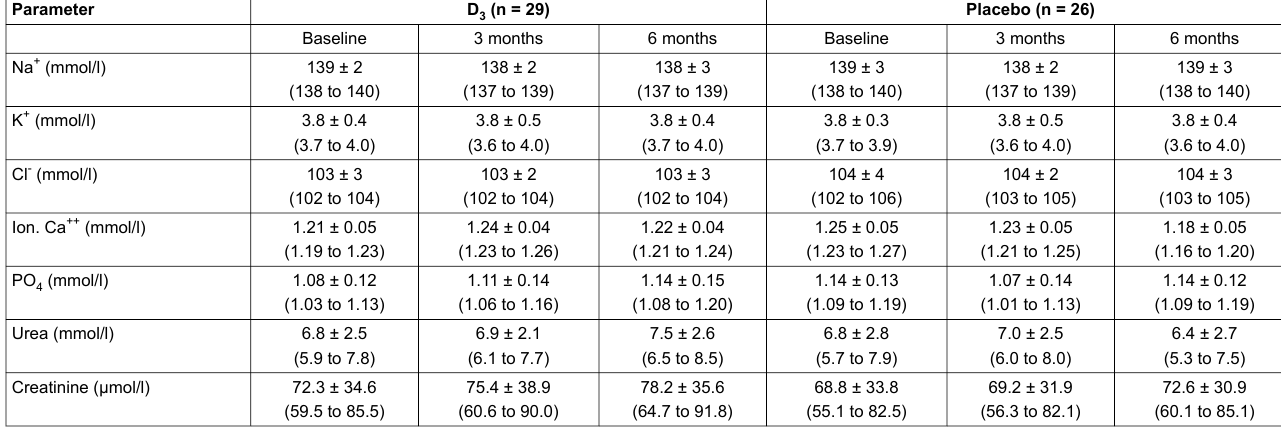
Table 4 : Effect of vitamin D (D 3 ) supplementation on plasma electrolytes, urea and creatinine (mean ± standard deviation, 95% confidence interval).